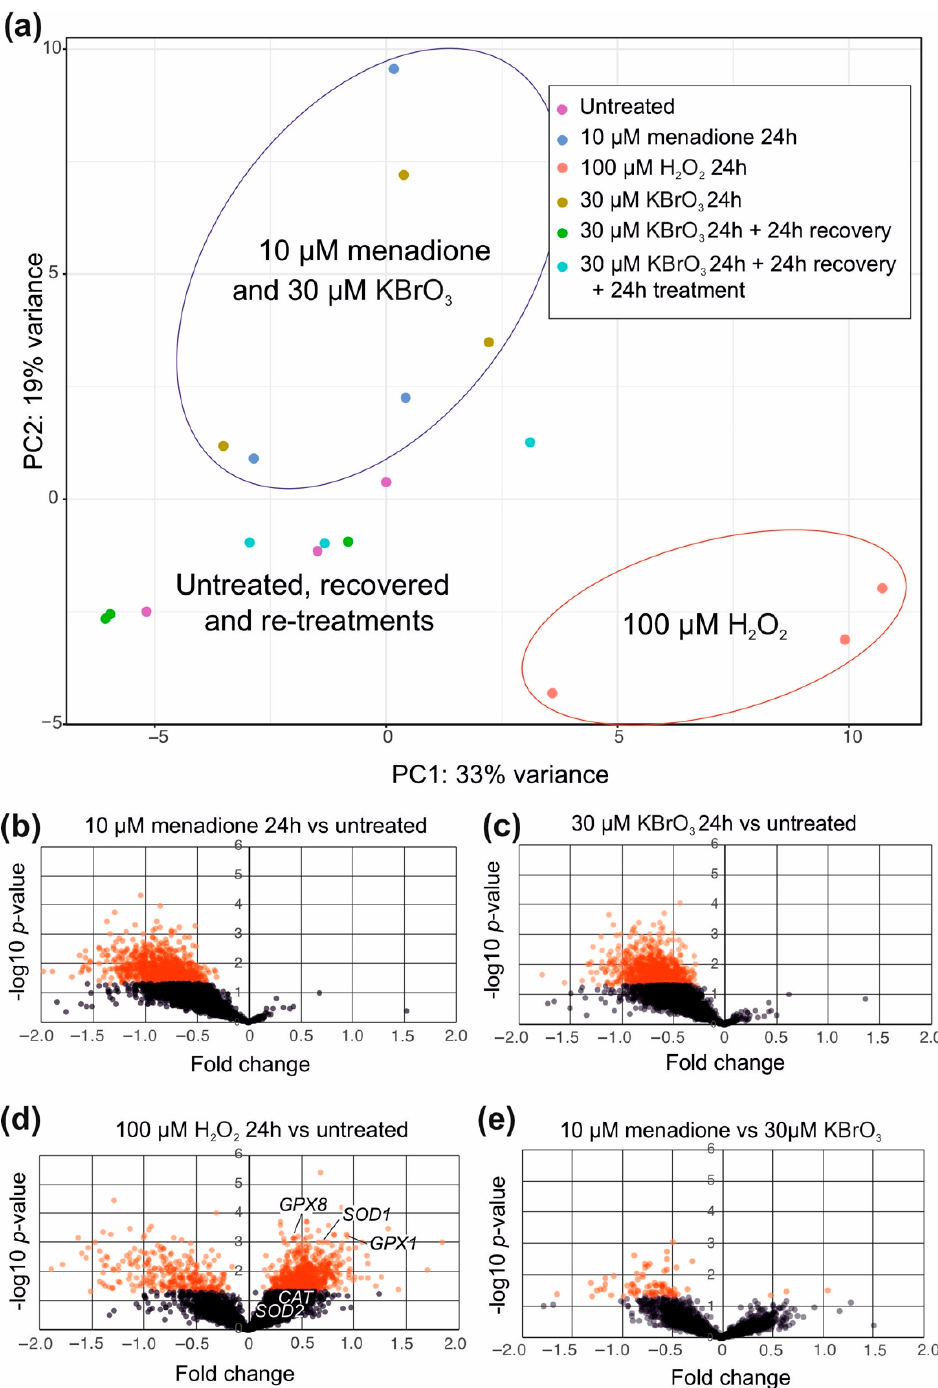
Figure 3. Global gene expression changes during and after oxidative stress. ( a ) Principal component analysis (PCA) of the treated cells as indicated in the legend. Menadione and KBrO 3 exposure cause similar changes in the transcriptome, whereas H 2 O 2 treated cells differ from these as well as from control cells. Untreated controls, cells recovered from KBrO 3 exposure for 24 h, and cells retreated with KBrO 3 after recovery also cluster together. ( b ) A volcano plot showing down- (left) and up- (right) regulated genes after 24 h menadione treatment. The y-axis indicates the inverse log10 t-test p -value. Genes having p -values below 0.05 are shown in red. ( c ) The KBrO 3 -treated cells show a similar, general reduction in gene expression as the menadione-treated cells. ( d ) In contrast, H 2 O 2 treatment results in differential up- and downregulation of dozens of genes. Antioxidant defense genes, such as SOD1 and GPXs are among the upregulated genes. ( e ) 10 μ M menadione treatment causes a more exaggerated reduction in transcriptional activity than 30 μ M KBrO 3 .